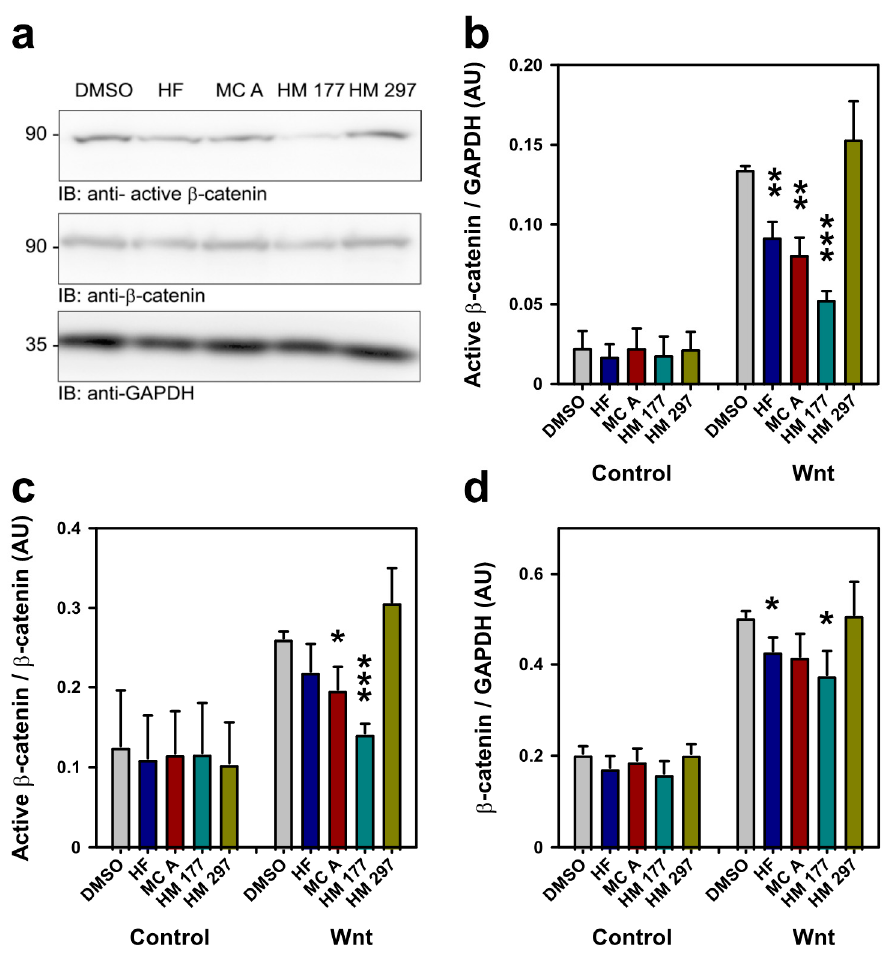
Figure 8. Down-regulation of active β -catenin in response to treatment with HF and MCs. STF293 cells were stimulated with Wnt3a-conditioned medium for 6 h before compounds were added at 3 µ M for further 20 h. Cell lysates were analyzed by SDS-PAGE and Western blotting with the indicated antibodies. ( a ) Representative Western blot analysis of active β -catenin, total β -catenin and GAPDH (loading control). Quantification of chemiluminescence signals depicted as ( b ) active β -catenin relative to GAPDH levels, ( c ) active β -catenin to total β -catenin levels or ( d ) total β -catenin to GAPDH levels. Results were obtained from 6 independent experiments. * p < 0.05; ** p < 0.01; *** p < 0.001 (paired Student’s t